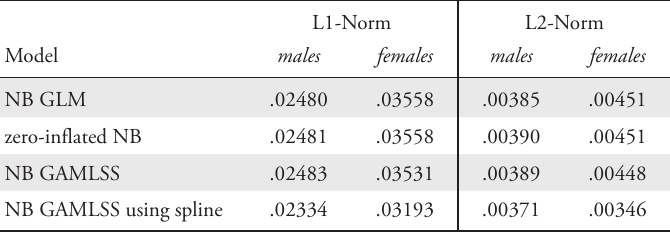
Table 5: L1 and L2-Norm prediction errors of case